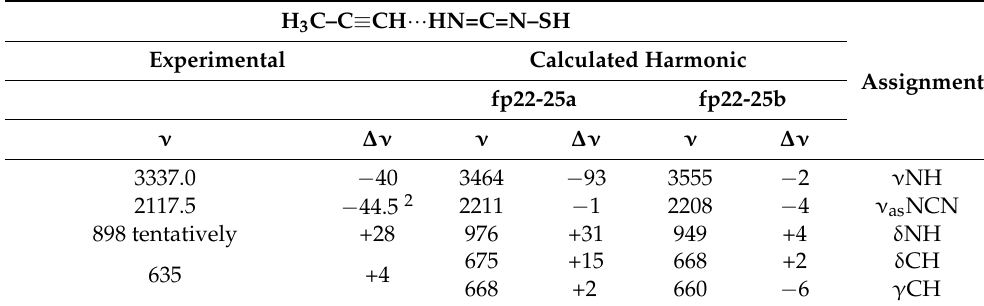
Figure 8. B3LYP/6-311++G(3df,3pd) optimized structure of the H 3 C–C ≡ CH ··· HN=C=N–SH com- plex. The selected bond distances (in Å) and interaction energies ∆ E CP (in kJ mol − 1 ) are given. Table 7. Wavenumbers and wavenumbers shifts ( ∆ ν = ( ν comp − ν mon )) (in cm − 1 ) calculated and observed for the H 3 C–C ≡ CH ··· HN=C=N–SH complex in solid argon 1